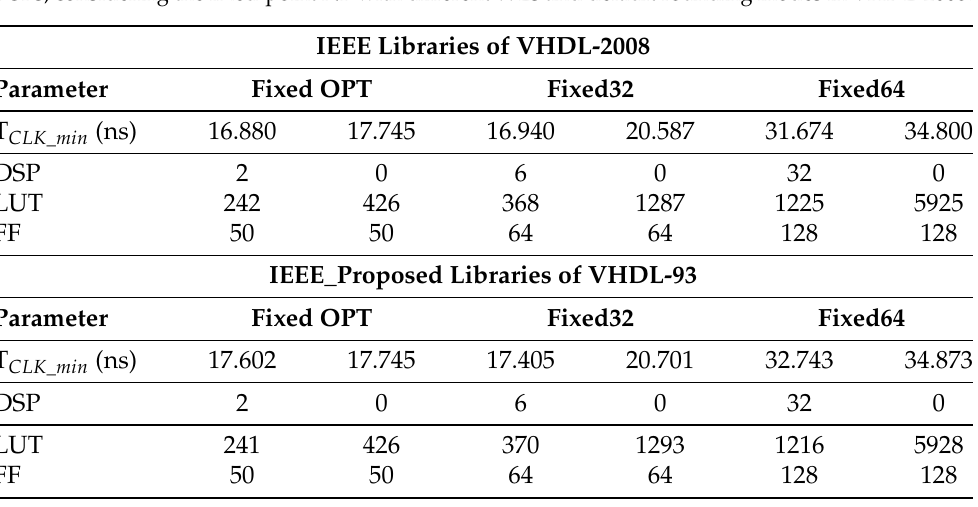
Table 4. Hardware needs in terms of speed (T CLK _ min ) and area (LUTs and FFs) with and without DSPs, considering the fixed-point NF with different WLs and default rounding modes in VHDL-2008.